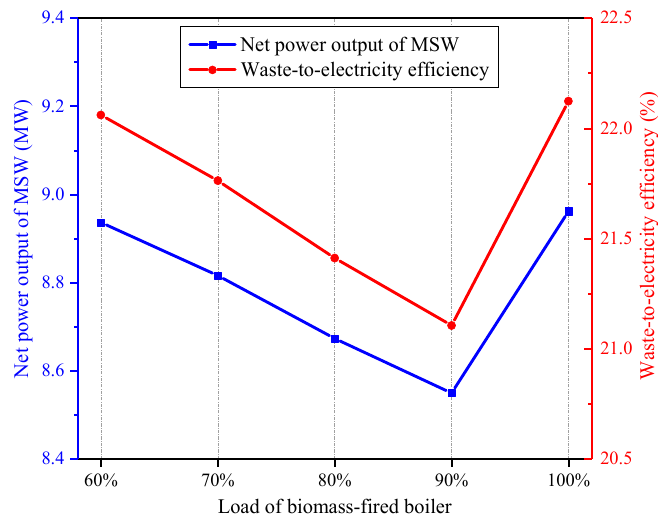
Figure 6. Effect of the biomass-fired boiler load on the performance of the integrated WtE system.